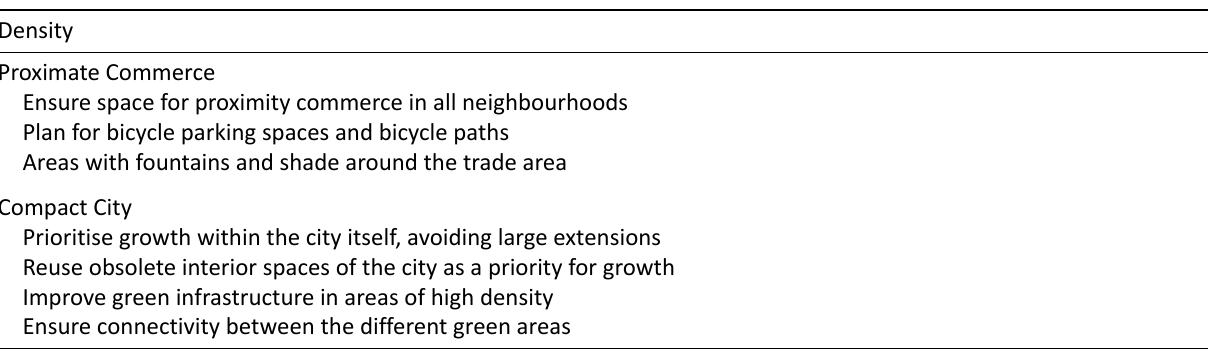
Table 1. The healthy urban planning action checklist for urban